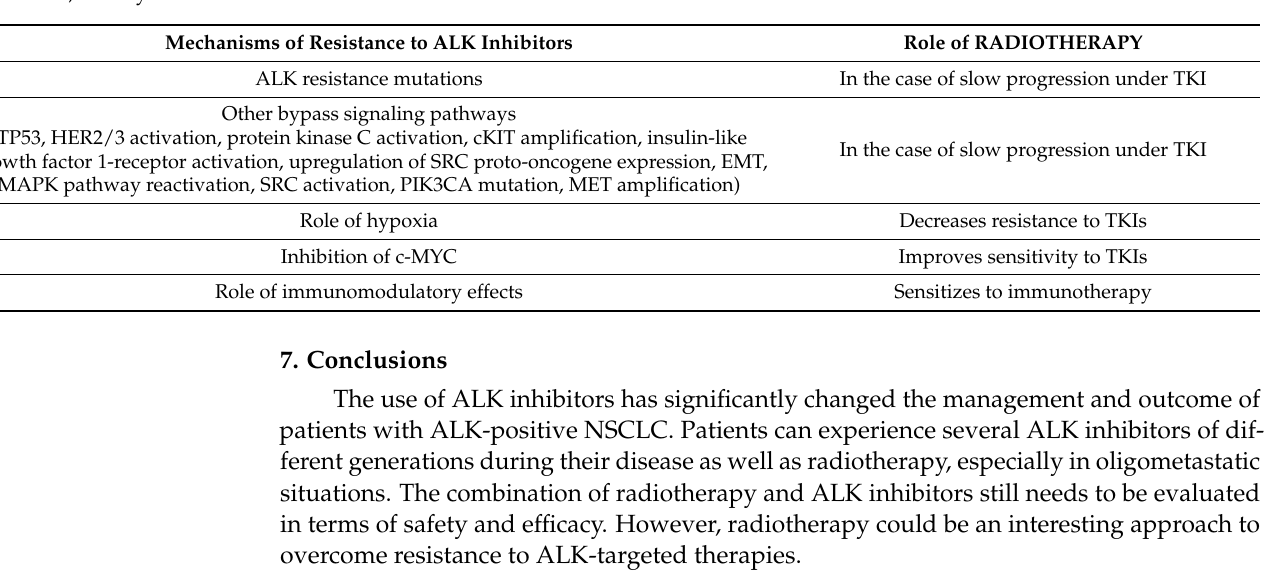
Figure 3. Role of the immune response to ALK inhibitors and role of radiation therapy. ALK: anaplastic lymphoma kinase, RT: radiotherapy, PD-L1: programmed death ligand 1, NSCLC: non-small cell lung carcinoma. Table 3. Different mechanisms of resistance to ALK inhibitors and the role of radiation therapy. ALK: anaplastic lymphoma kinase, TKI: tyrosine kinase